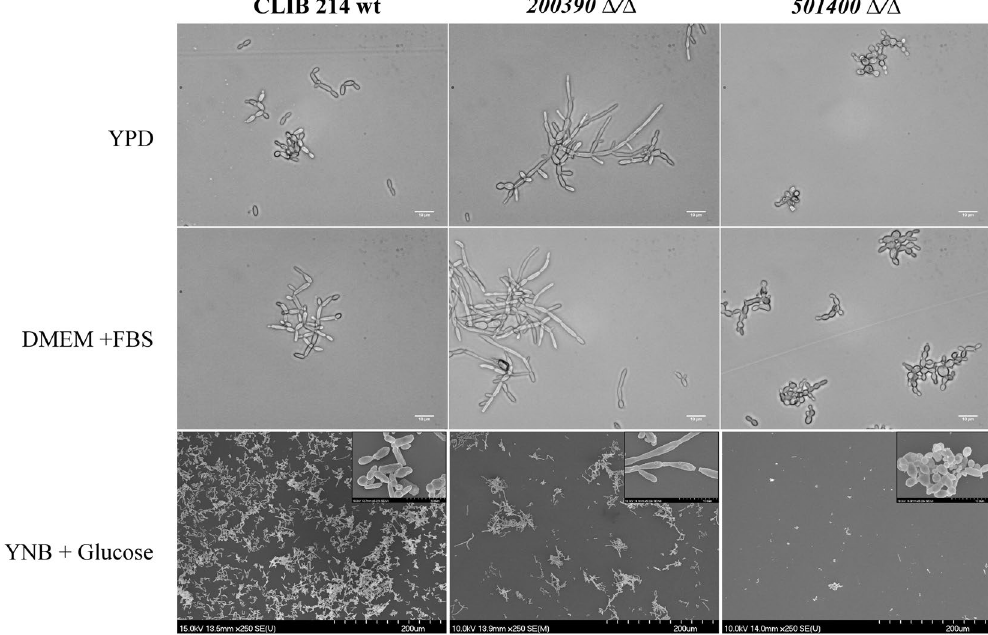
Figure 2. Pseudohyphal growth of the C. parapsilosis mutant strains. DIC and SEM images of pseudohyphae produced by the wild-type (CLIB 214) CPAR2_200390 Δ / Δ and CPAR2_501400 Δ / Δ strains 48 hours after cultivation in YPD, FBS supplemented DMEM and YNB + glucose liquid medium. Scale bars: 10 µ m and 200 µ